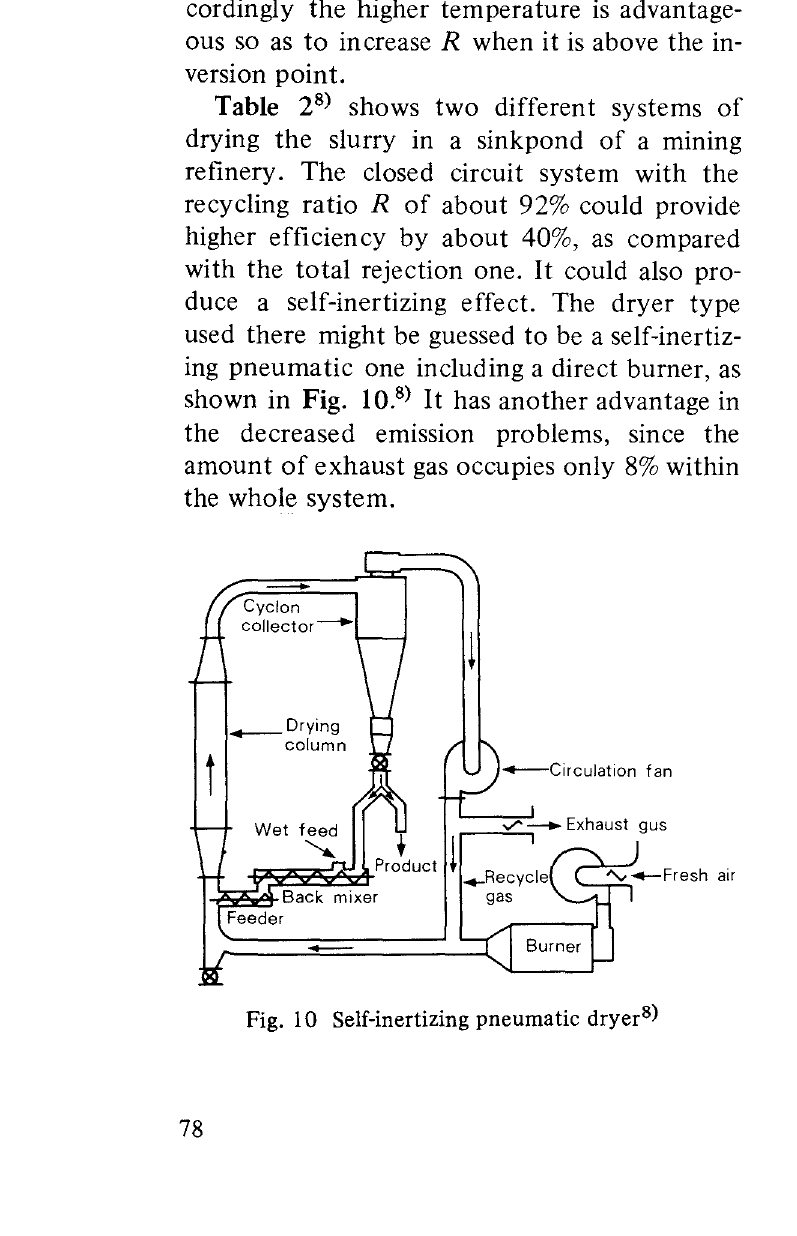
Fig. 10 Self-inertizing pneumatic dryer